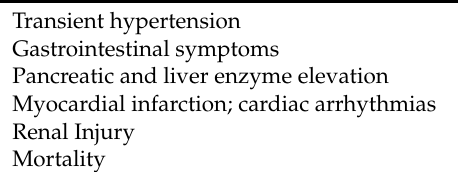
Table 1. Hemoglobin-based oxygen carriers /HBOCs) associated adverse events 1